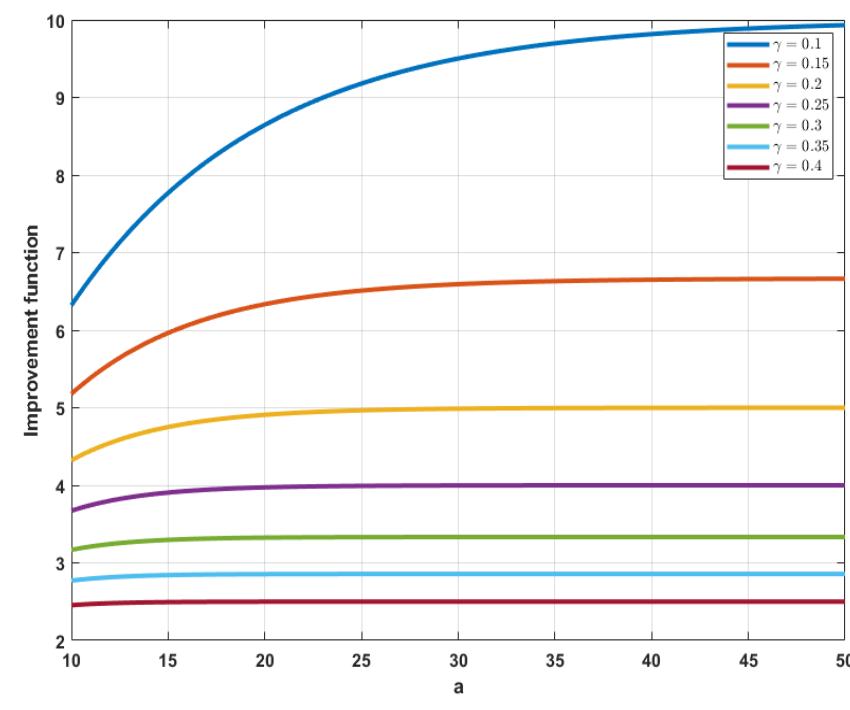
Figure 7. The exponential utility function with γ = { 0.1,0.15,0.2,0.25,0.3,0.35,0.4 } .